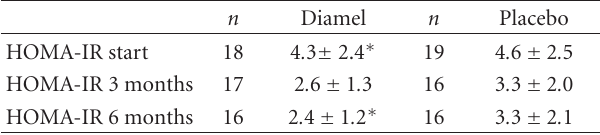
Table 5: Evolution of the insulin resistance index (HOMA-IR) in patients with the polycystic ovary syndrome.